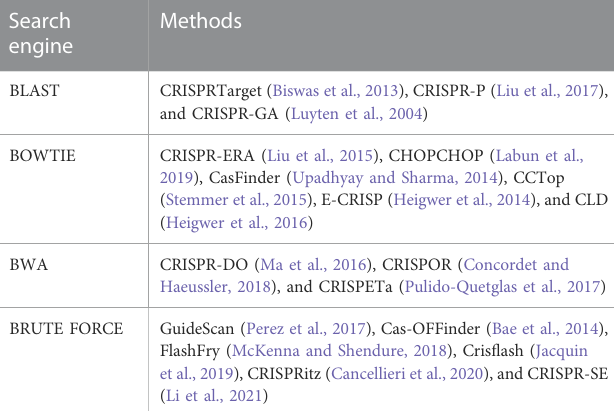
TABLE5Themostpopularalignment-basedmethodsandrelatedsearchengines. Search